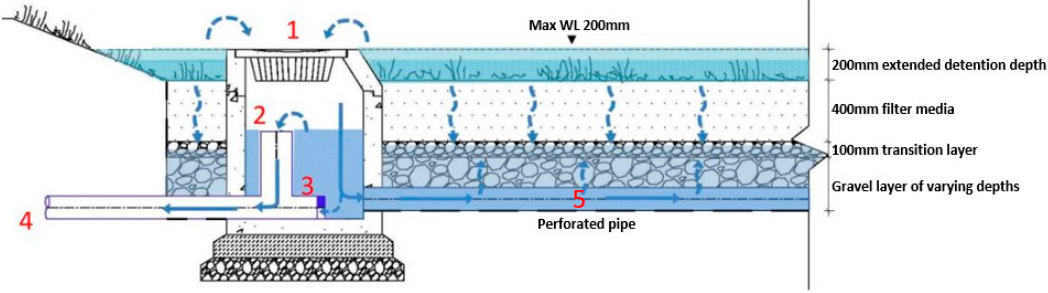
Figure 3. Cross section of a rain garden with overflow manhole in Waterway Ridges.